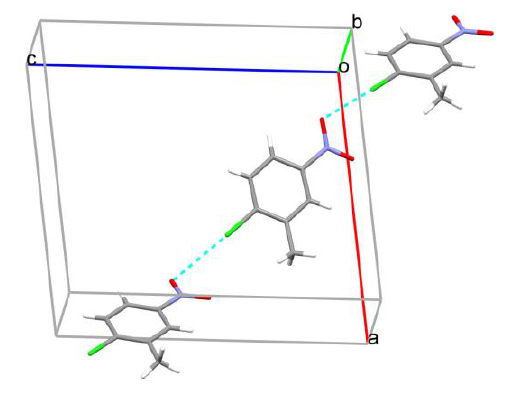
Figure 5. Short Cl…O contacts forming chains along the [ 010 ] diagonal [17].